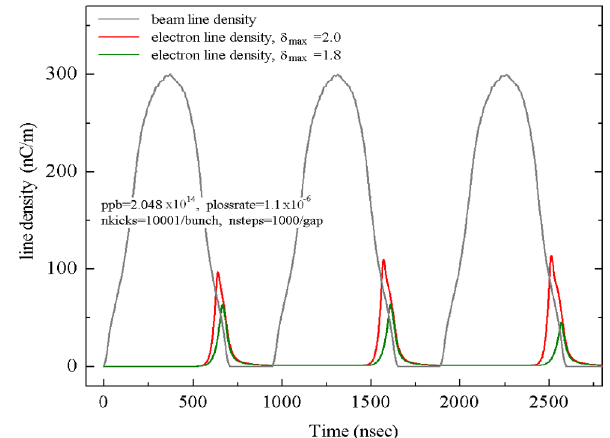
.FIG. 2. (Color) Experimental data from PSR and simulated FIG. 4. (Color) Simulated electron density during the first decay time of the electron cloud at the end of a beam pulse bunch passages, in a SNS field-free region, assuming (cid:3) (cid:3) 3 : 12 (cid:11) 10 13 or 5 (cid:30) C intensity. with bunch population N p (cid:3) 1 : 8 2 and (cid:3) Different SEY values for low energy electrons, (cid:3) (cid:1) 0 (cid:2) , have max (cid:3) 2 . been assumed in the simulation, with (cid:3) max